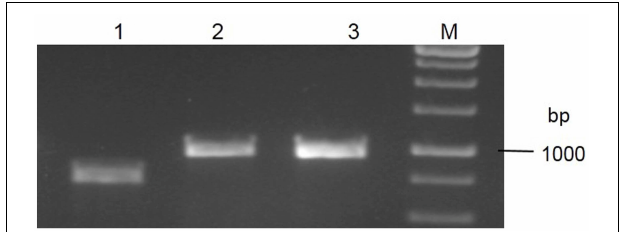
FIGURE 1 | PCR amplification of different fragments of Pi54 allele of rice landrace, Tiyun. bp- Base pairs, M- Molecular weight marker and lanes 1–3, PCR fragments obtained from overlapping fragments of Pi-54 allele.